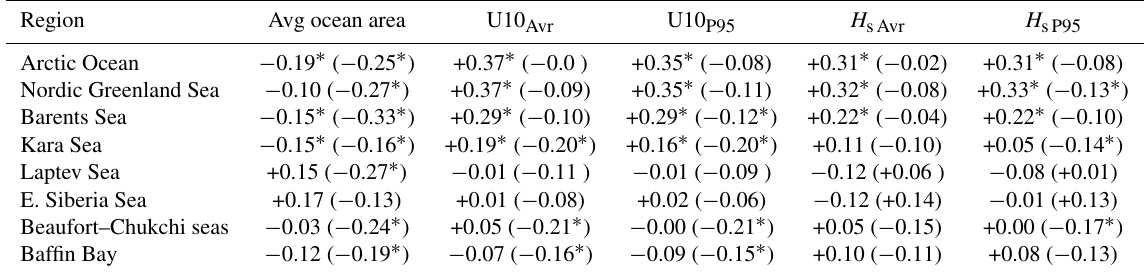
Table 1. Correlation coefficients and trends for the various regions and parameters. The correlations coefficients are given between area- averaged monthly time series versus the North Atlantic Oscillation and the Pacific Decadal Oscillation in parentheses. Statistically significant results are given by the * when the p value is less than